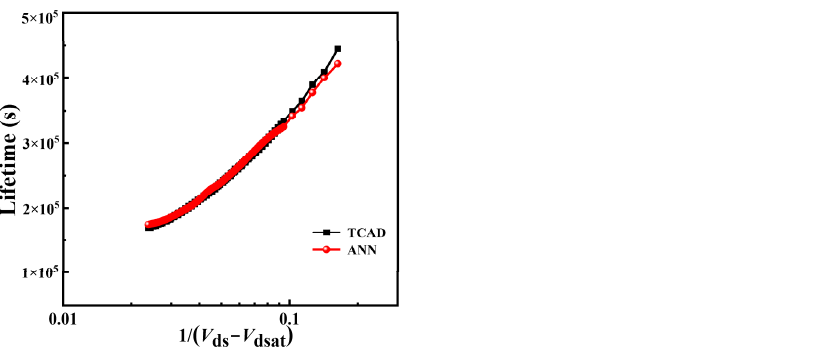
Figure 12. Comparison of the ANN algorithm in lifetime prediction.